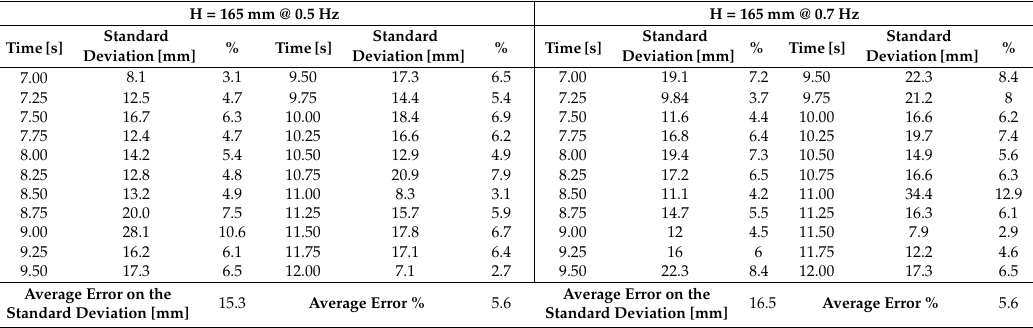
Table 7. Model output for the free surface ( Test 3